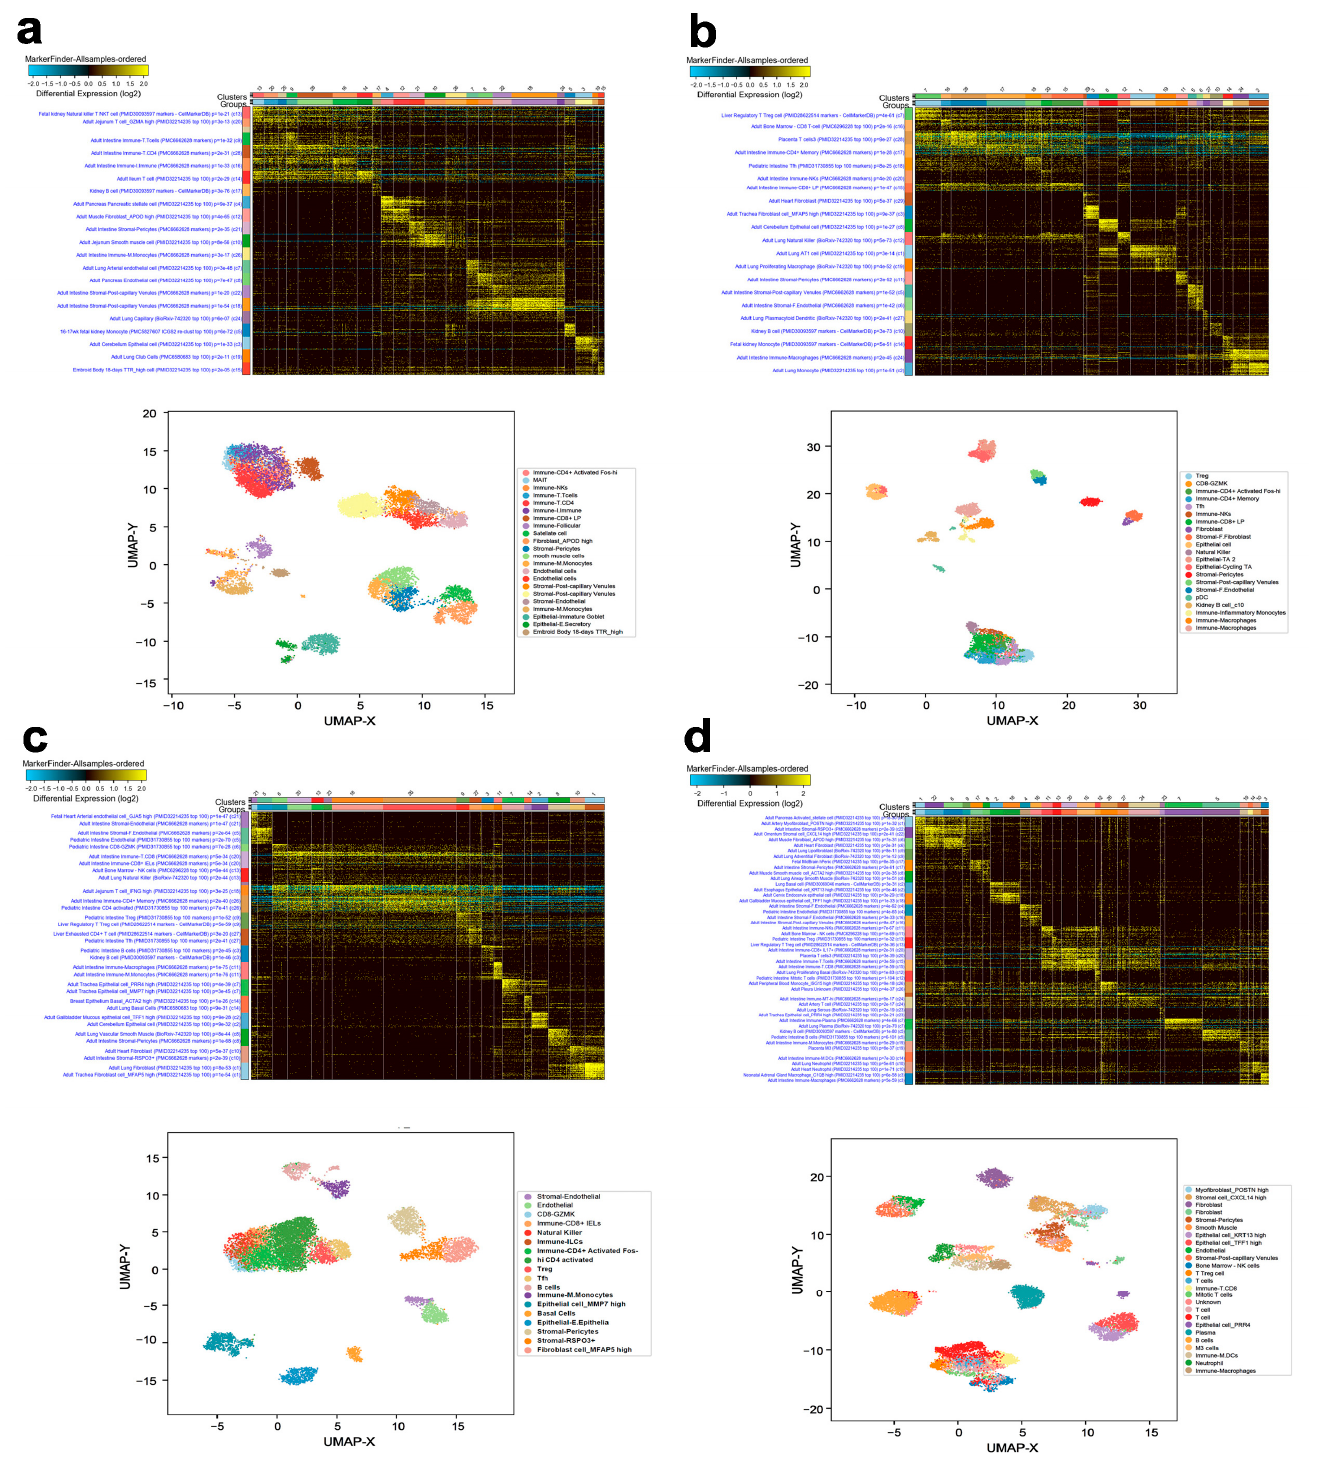
Figure 1. BC heterogeneity delineated by single-cell transcriptome analysis. Single-cell analysis of a total of 16,350 single cells derived from 12 ER + BC ( a ), 7824 single cells derived from 3 HER2 + BC ( b ), 11,487 cells derived from 2 ER + HER2 + BC ( c ), and 14,238 single cells derived from 9 TNBC ( d ) employing AltAnalyze algorithm depicted as heat map. The lower panels represent UMAP dimensionality reduction visualization of the identified cell clusters. The text on the left of each heatmap indicates enriched cell-type markers from the default gene-set enrichment analysis and corresponding “Z” score p value.